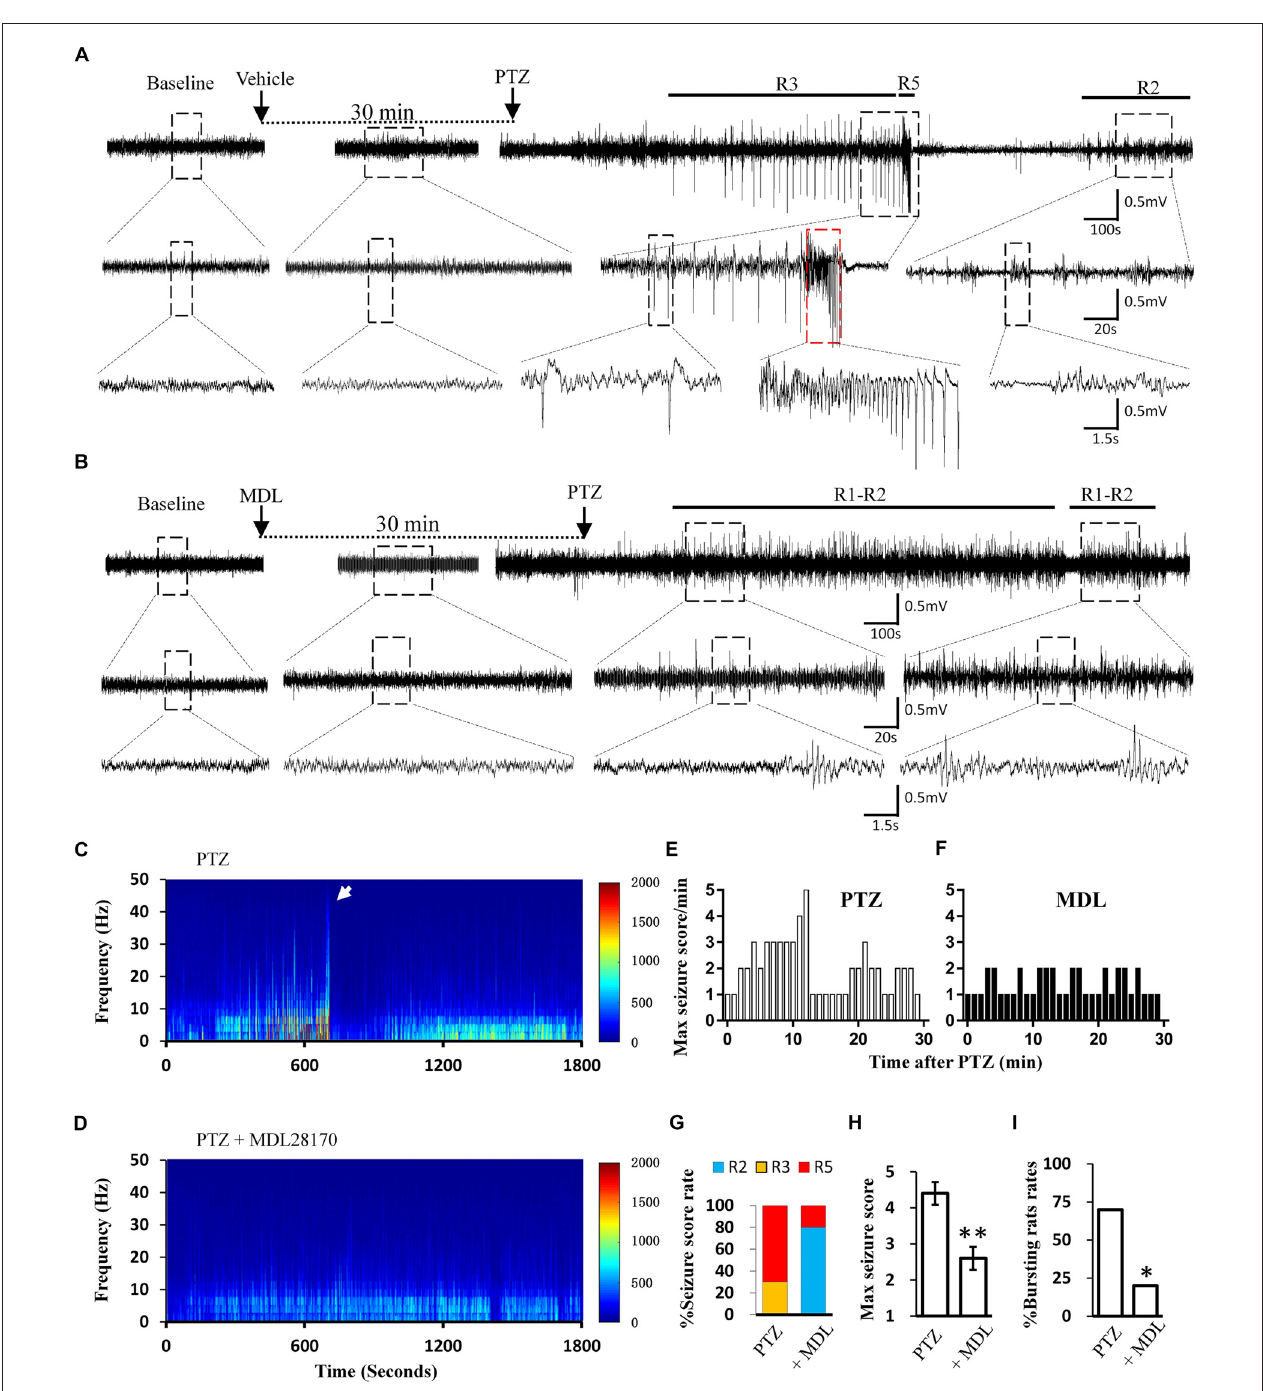
FIGURE 1 | Electroencephalograph (EEG) and behavioral analysis showing improvements after MDL-28170 intervention on pentylenetetrazole (PTZ)-induced acute seizures. (A,B) typical EEG recordings from vehicle group (A) and MDL-28170 pre-treatment group (B) at selected time points. The lower traces are the enlarged traces from the dashed boxes of upper traces. The red dashed box marks an intermittent presence of high amplitude fast discharges (HAFDs) within the continuous rhythmic spike-wave activity. (C,D) EEG power from the recording of above traces was plotted against time, starting from the administration of PTZ and lasting for 30 min. The white arrow marks the HAFDs. (E,F) The static behavioral seizure scores over the 30 min period from two representative individual rats in the two groups illustrated in panel. (G) Proportion of rats with different seizure scores. R2, R3 and R5 represent the seizure score of Racine2, Racine3 and Racine5, respectively. (H) The average of the maximal behavior scores for rats from either PTZ or PTZ + MDL group. (I) Rate of animal with bursts and HAFDs within the two groups. ∗ p < 0.05 compared with PTZ group; ∗∗ p < 0.01 compared with PTZ group.